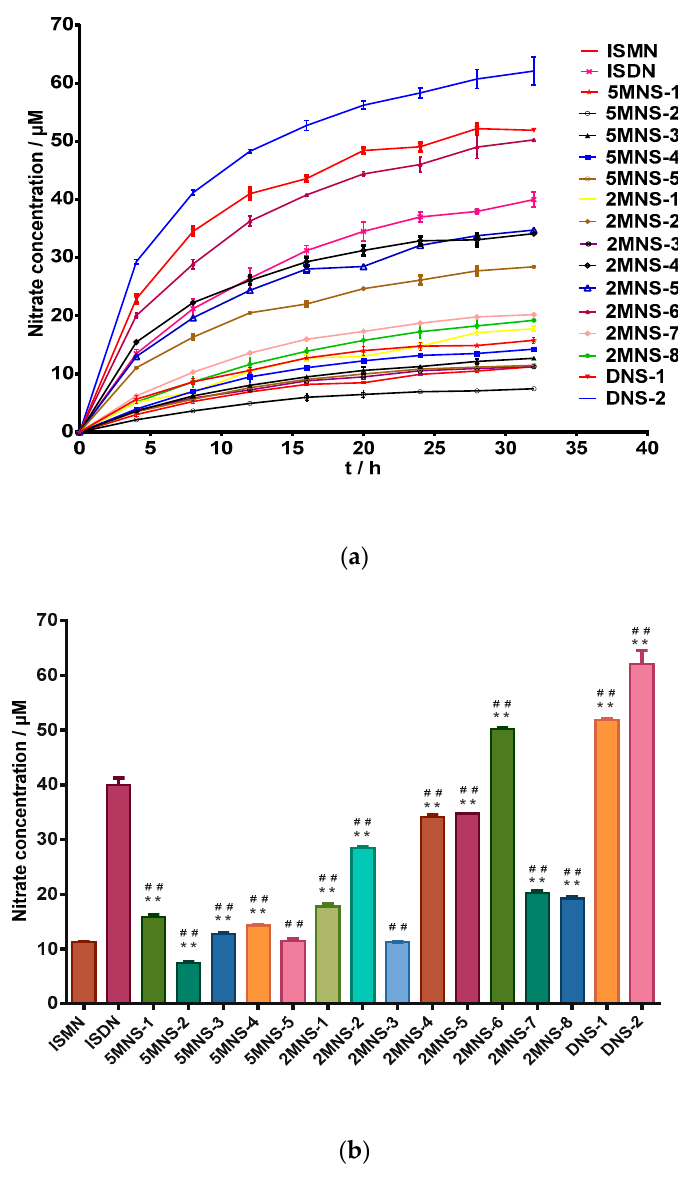
Figure 3. ( a ) level of nitrite for the test compounds (100 μ M) over duration of 32 h by Griess assay. ( b ) Nitrate concentration for the test compounds (100 μ M) at 32 h by Griess assay. Data are expressed as the mean ±SD (n = 6). * p < 0.05, ** p < 0.01 vs ISMN, # p < 0.05, ## p < 0.01 vs ISDN.